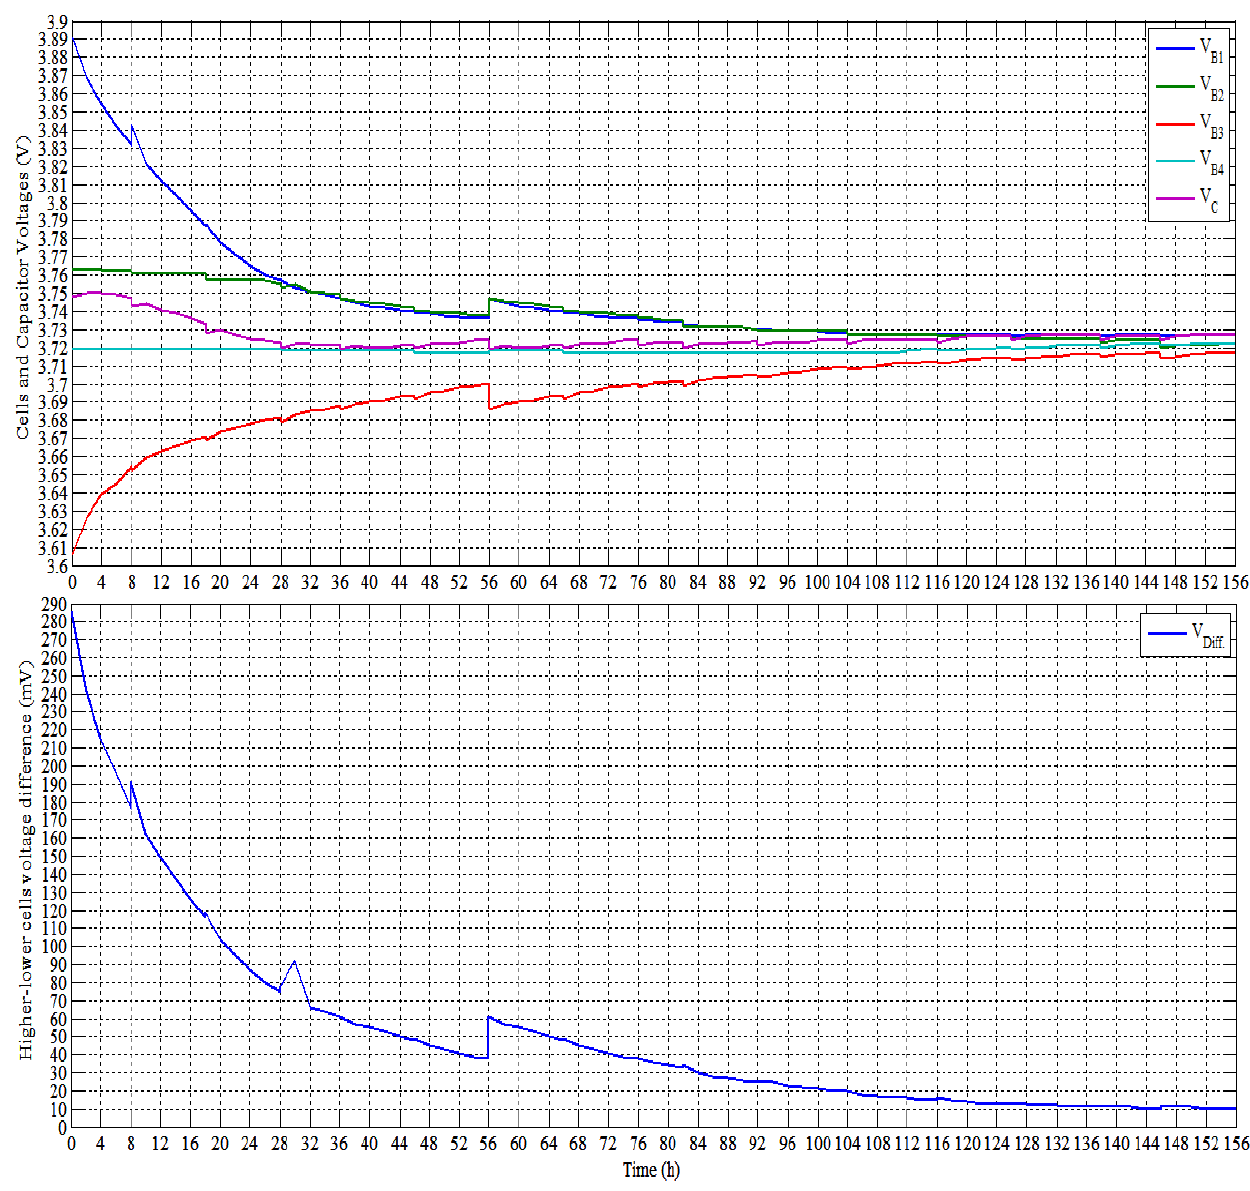
Figure 35. Experimental results of 20 A·h cells with SSC closed-loop balancing (Test No.